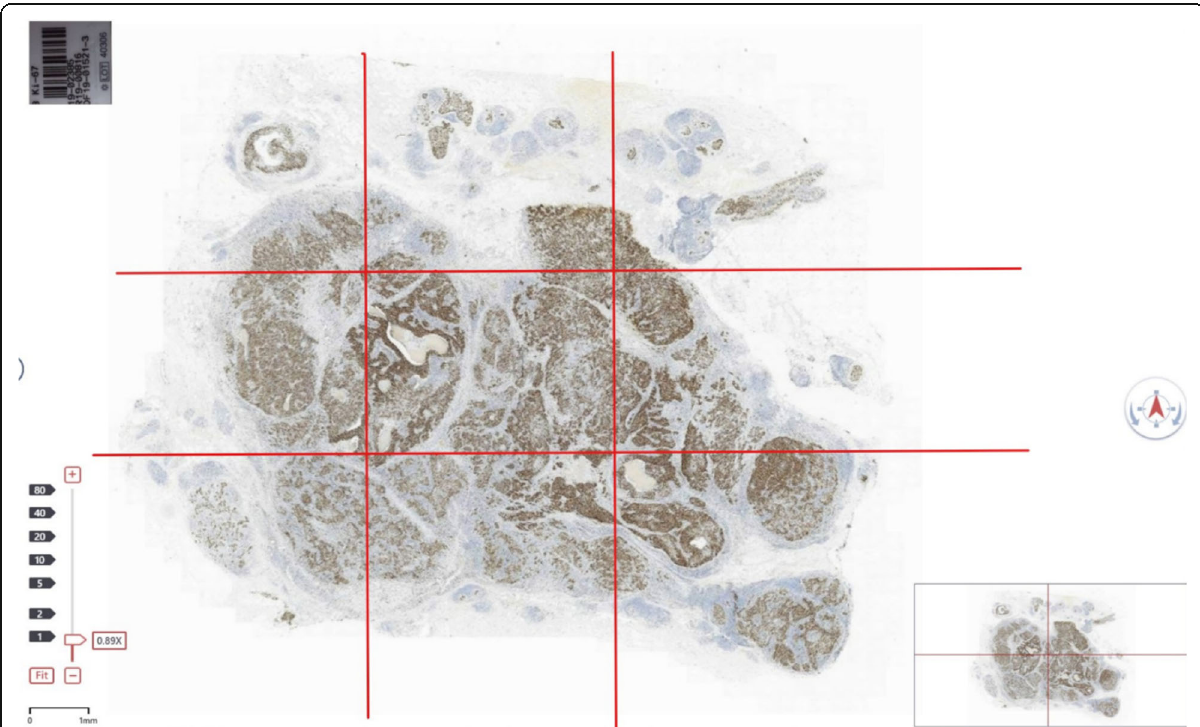
Fig. 3 Whole slide imaging (WSI). Each digital slice was divided into 9 areas, and AI automatically counted the number of positive tumor